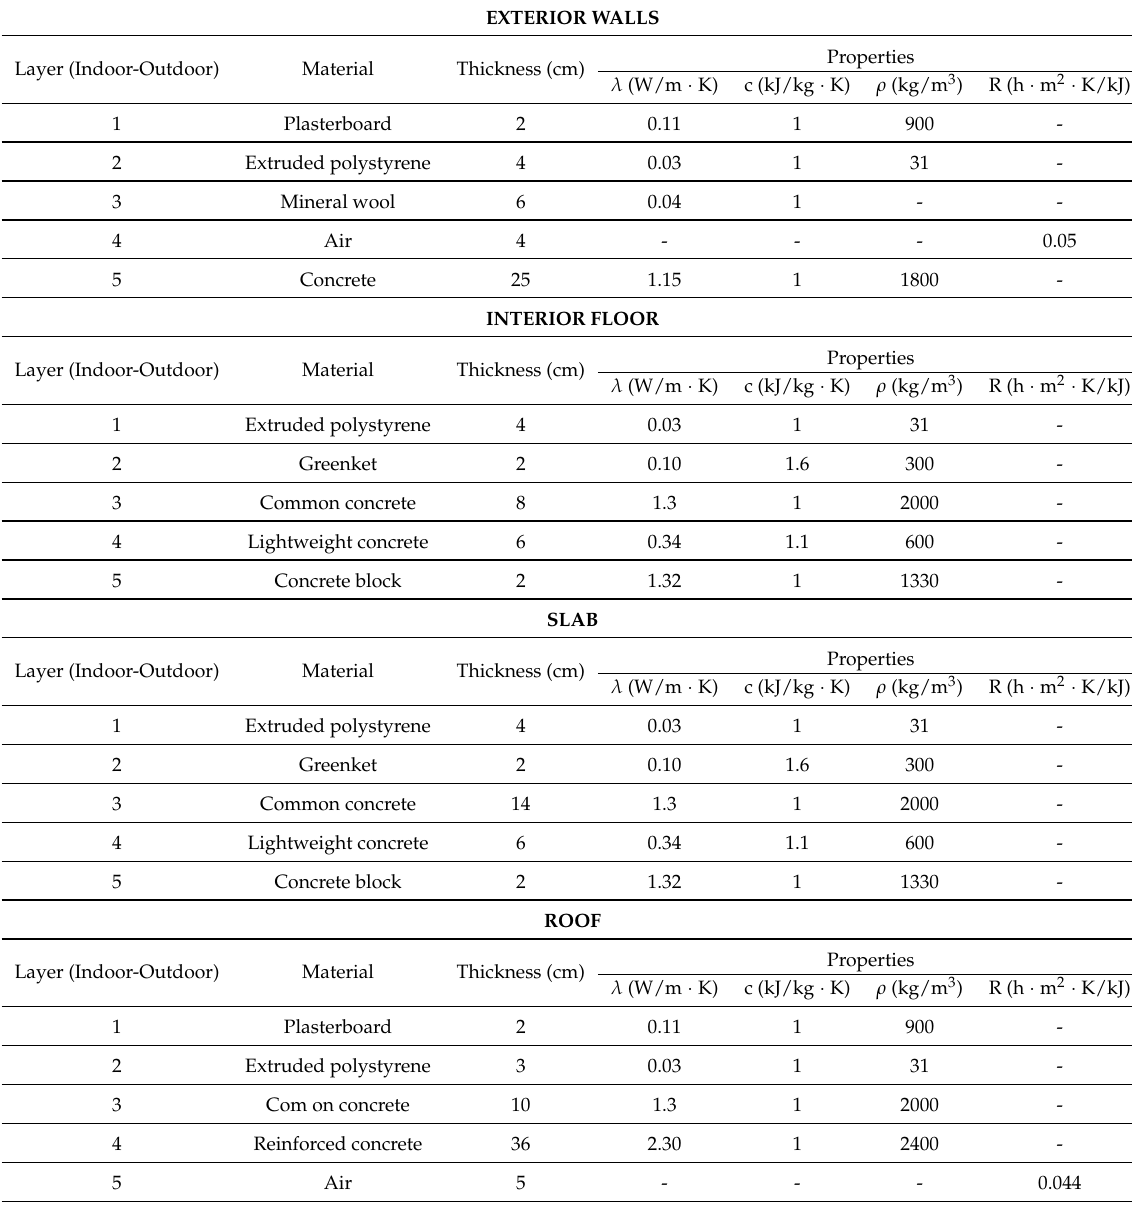
Table 1. Composition and properties of the enclosures of the analysed